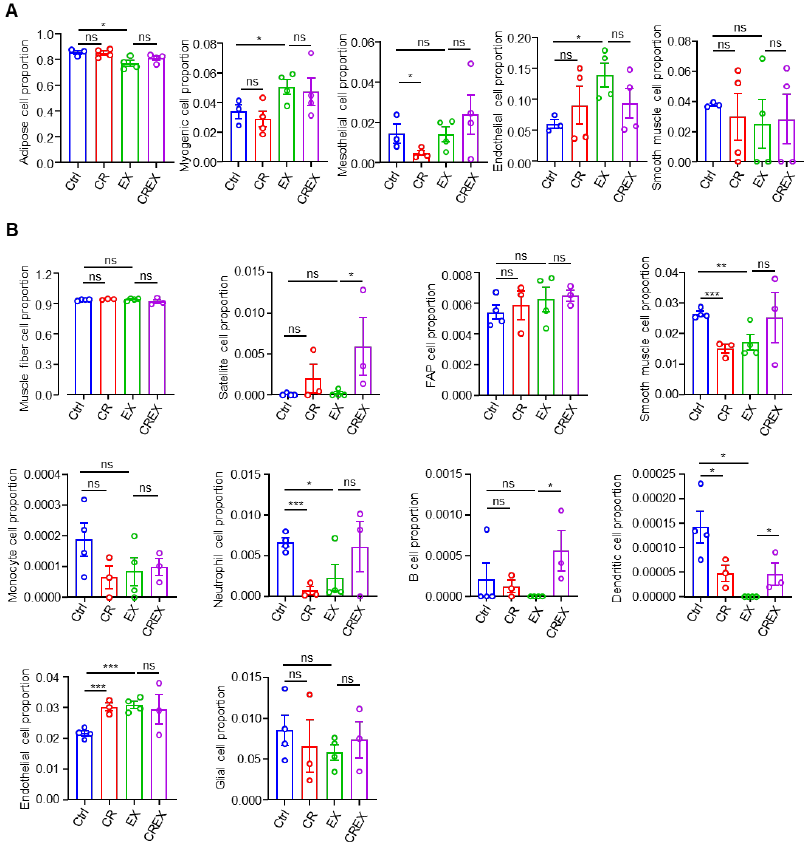
Figure 6. Cell proportion alterations as a result of CR with or without EX across the two tissues. ( A ) Boxplots of estimated cell type proportions in BAT bulk RNA sequencing from four intervention groups. Cell populations with numbers equal to or close to zero are not shown. ( B ) Boxplots of estimated cell type proportions in skeletal muscle bulk RNA sequencing from four intervention groups. Cell populations with numbers equal to or close to zero are not shown. Statistical significance was measured using unpaired one-tailed t tests or Wilcoxon rank sum and signed rank tests. Data are represented as means ± SEM. * p < 0.05, ** p < 0.01, *** p < 0.001; ns, not significant. FAP, fibro-adipogenic progenitor.